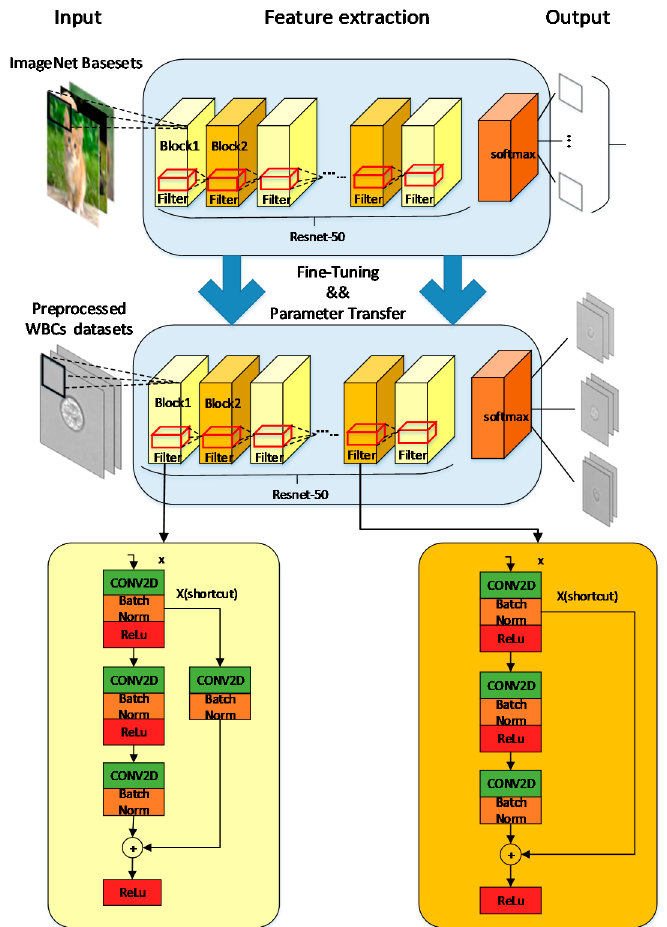
Figure 4. Diagram of Resnet-50 neural network with Identity Block shown on the bottom left and Conv Block shown on the bottom right.